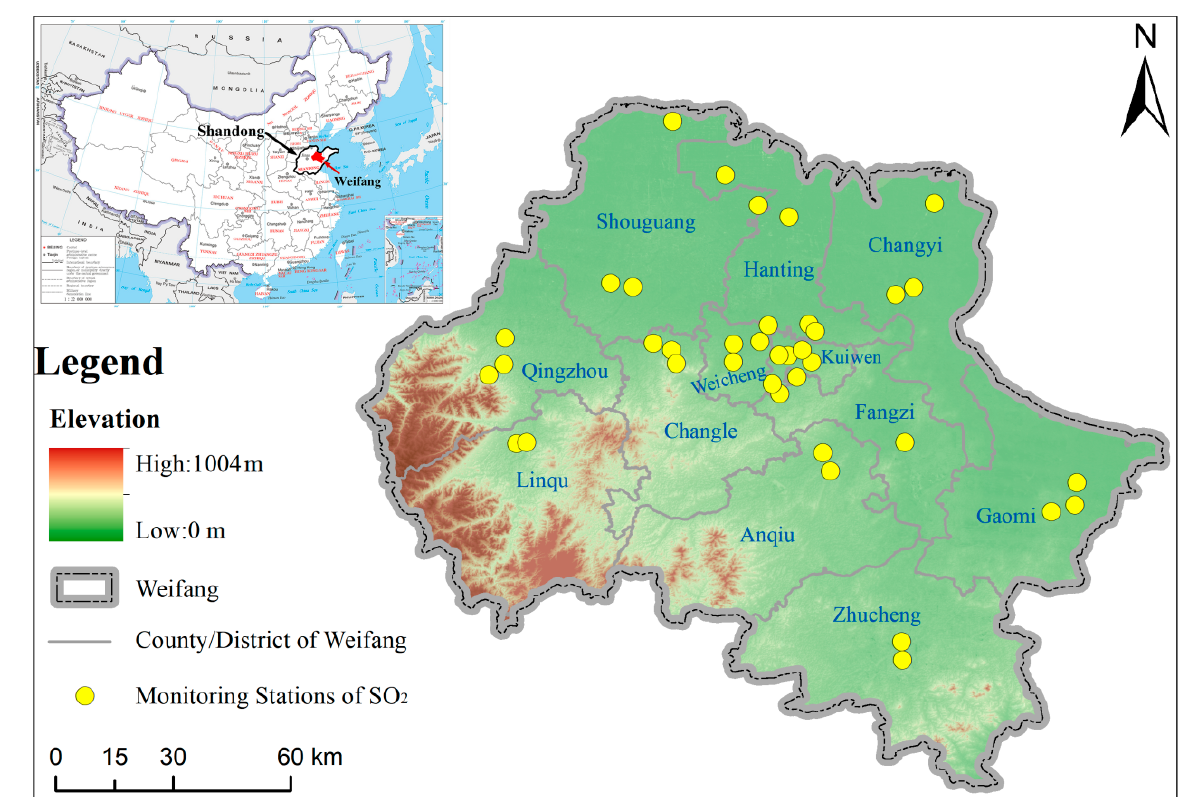
Figure 1. Study area and spatial distribution of monitoring stations.